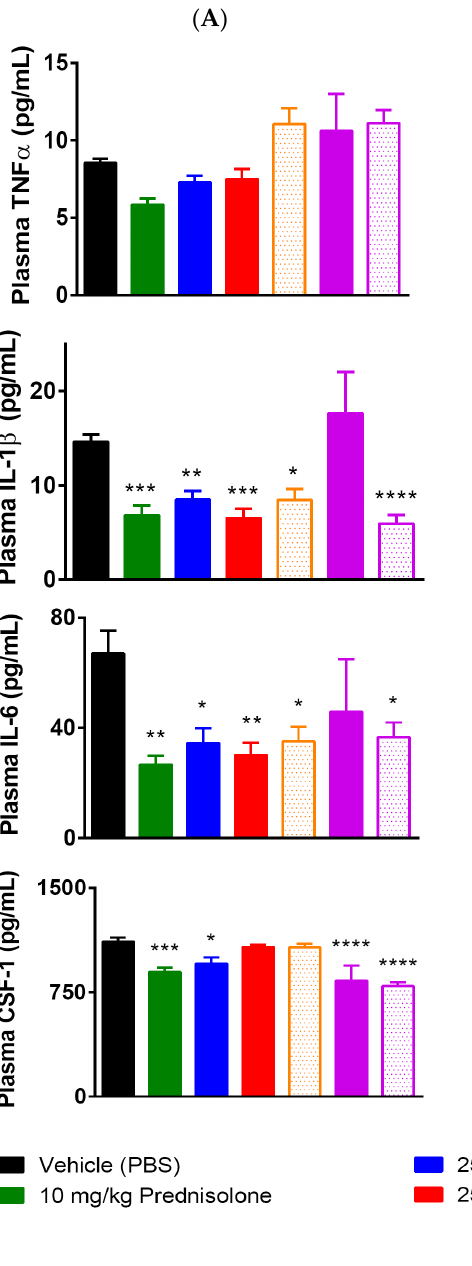
Figure 4. Effect of therapeutic treatment with free and LPC-bound IA9 and GF9 sequences on plasma ( A ) and joint (knee) ( B ) levels of proinflammatory cytokines. Data are shown as mean ± SEM ( n = 12). *, p < 0.05; **, p < 0.01; ***, p < 0.001; and ****, p < 0.0001 versus vehicle.